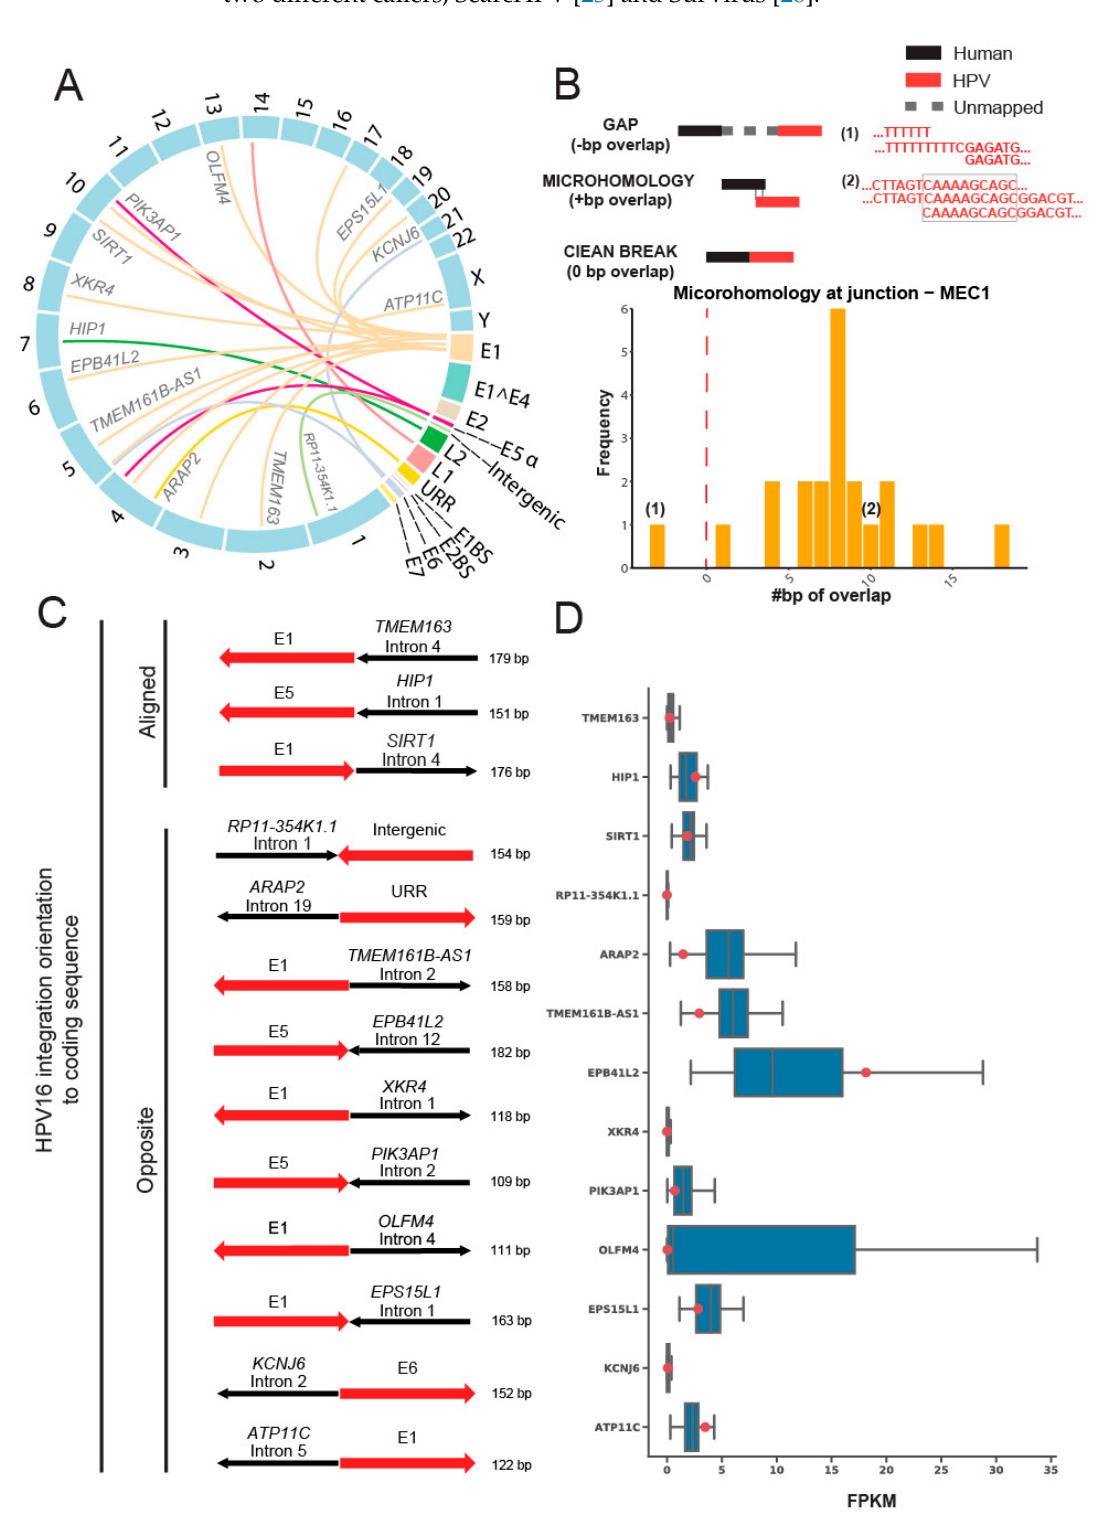
Figure 3. HPV16 integration site analysis in the host genome of MEC1. ( A ) Link plot of the